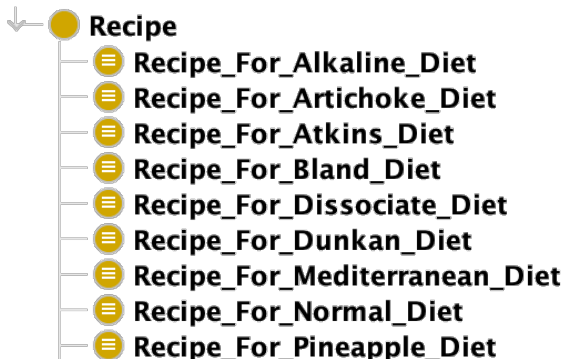
Figure 4. Hierarchy of recipes created for each specific diet.